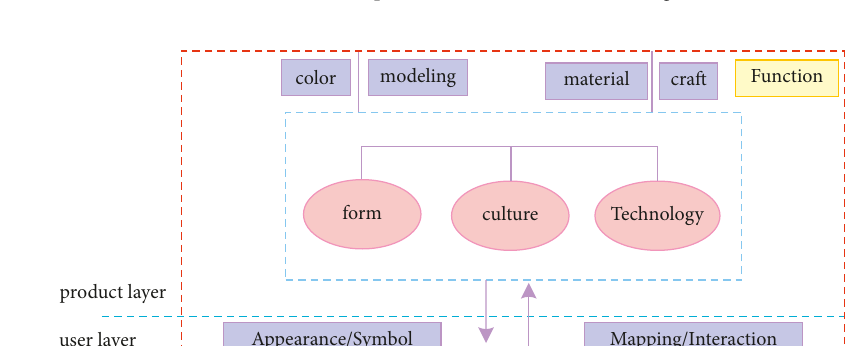
Figure 1: Development course of industrial design.